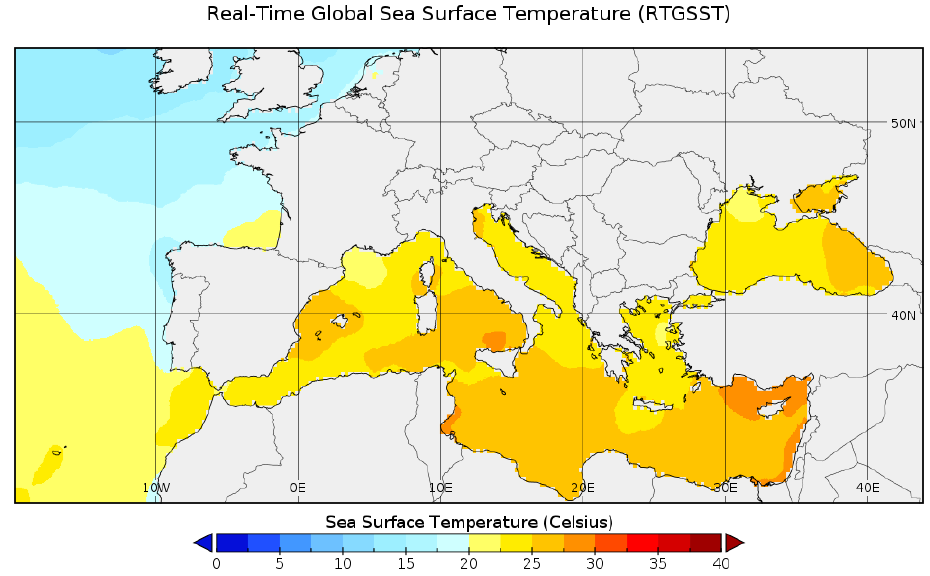
Figure 3. Values of RTGSST with a resolution of 0.083 degrees, referred to 15 July